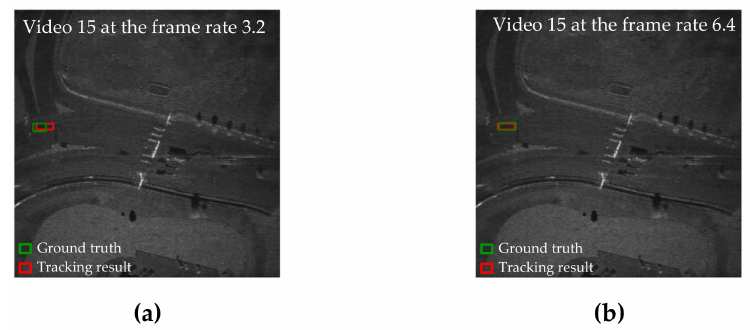
Figure 23. True tracking results of different frame rates: ( a ) Video 15 at a frame rate of 3.2; ( b ) Video 15 at a frame rate of 6.4 (Video 16).